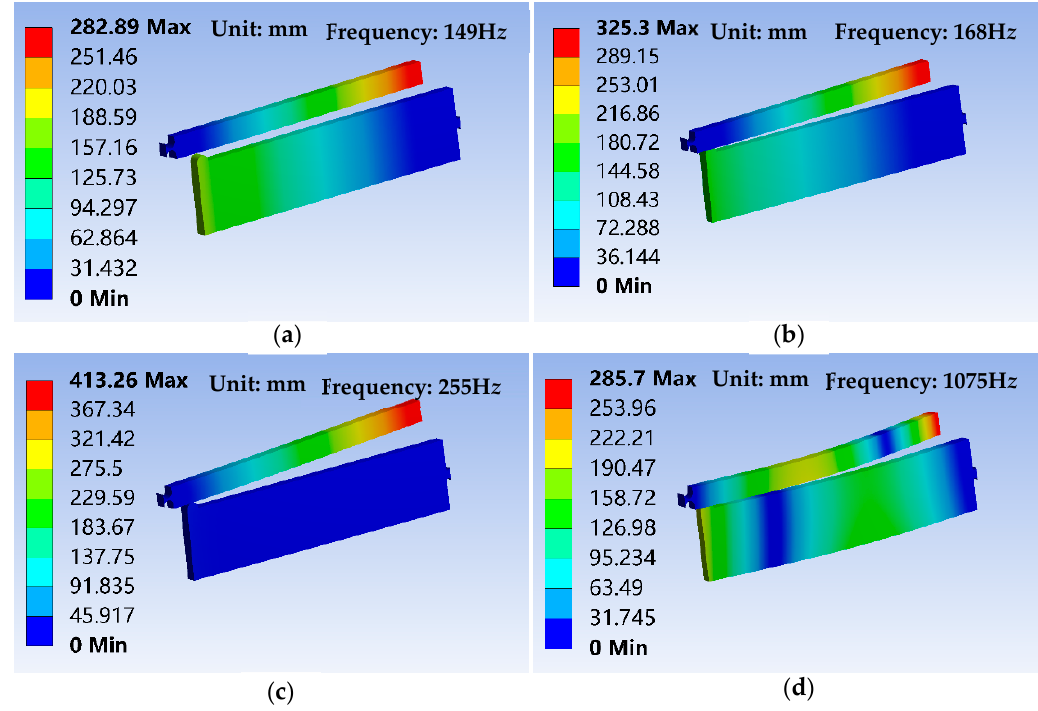
Figure 8. First four modes of vibration and natural frequencies of the two-stage flexural hinge lever-type mechanism. ( a ) The first order total deformation mode shape, ( b ) the second order total deformation mode shape, ( c ) the third order total deformation mode shape, and ( d ) the fourth order total deformation mode shape.